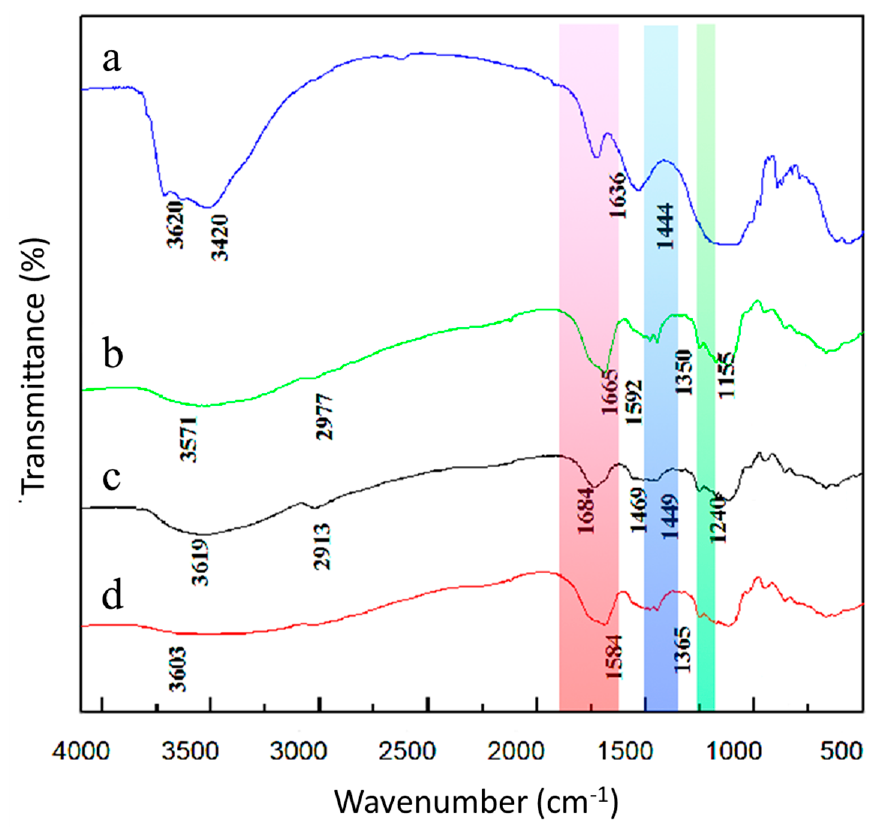
Figure 4. FTIR spectra: ( a ) APT; ( b ) APT − starch − lignin; ( c ) PAM − APT − lignin; and ( d ) PAM − APT − starch − lignin. Table 1. Physicochemical properties of sandy